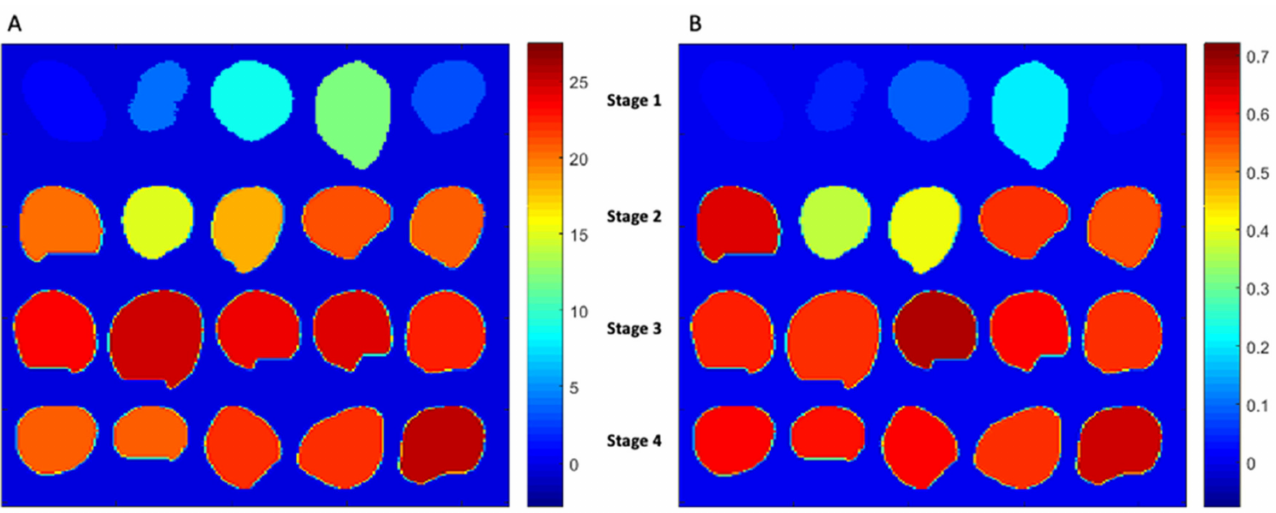
Figure 5. Prediction map of SSC (VIS-NIR range) ( A ) and TA (VIS-NIR range) ( B